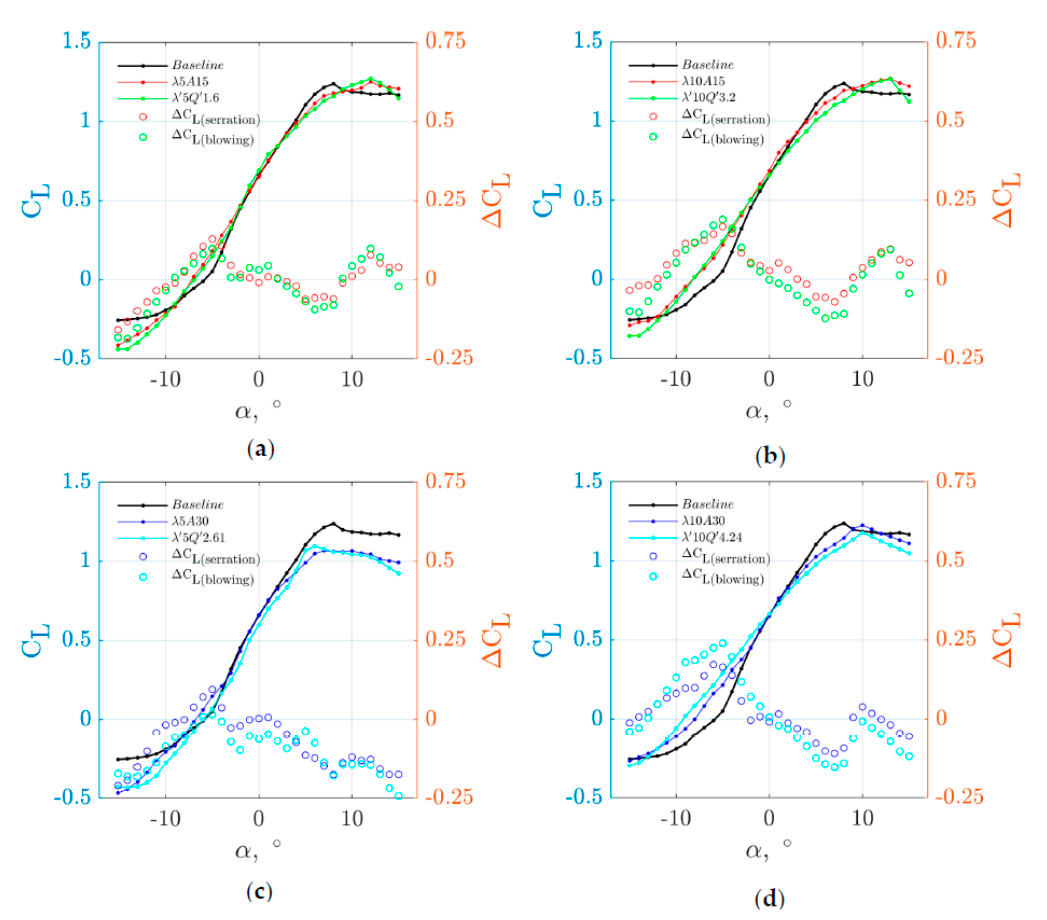
Figure 5. Comparison of the lift coefficient C L and Δ C L as a function of angle of attack α produced by serrated and blowing leading edges at U = 24 ms − 1 .